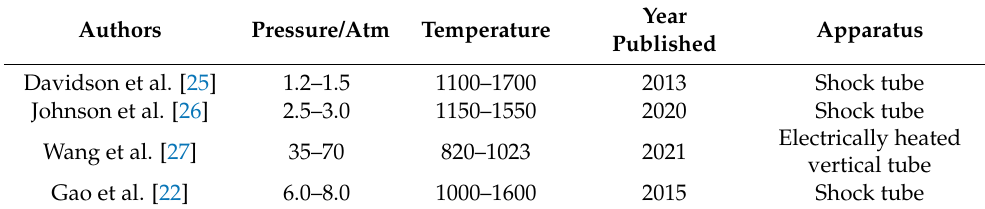
Table 2. A list of experimental studies of JP-10